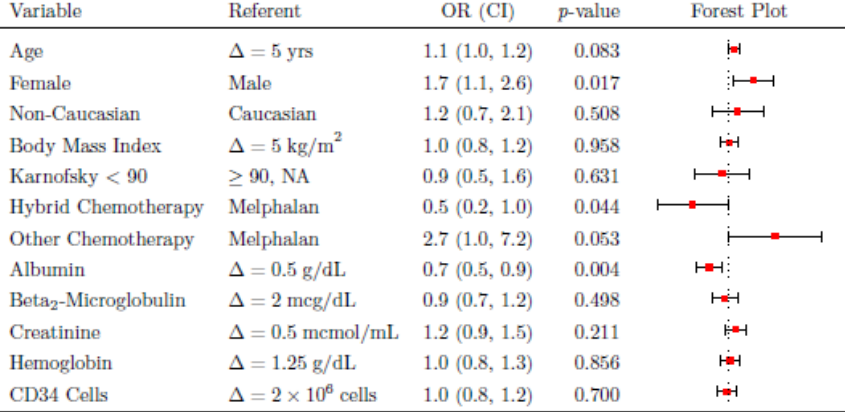
Figure 1. Clinical parameters associated with inpatient status (Group 1) for first ASCT ( A ). Variables associated with hospitalization in patients who started their first ASCT as outpatients (Groups 2 and 3) ( B ). OR = odds ratio, CI = confidence interval.